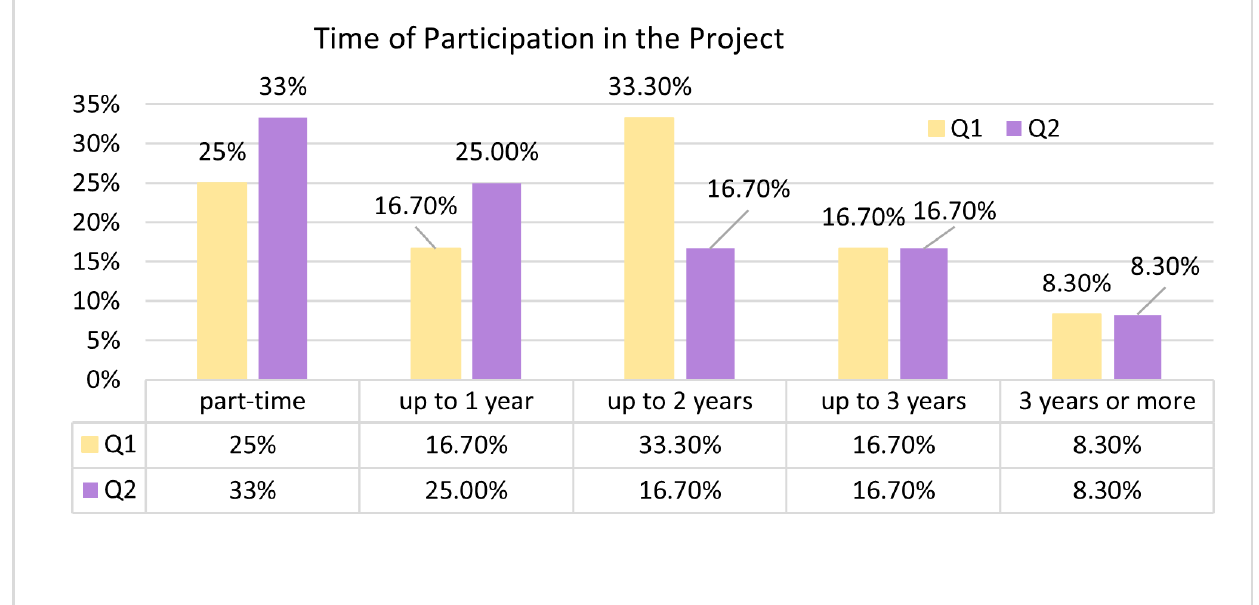
Figure 3. Time of participation in the project (questionnaire 1 and questionnaire 2).